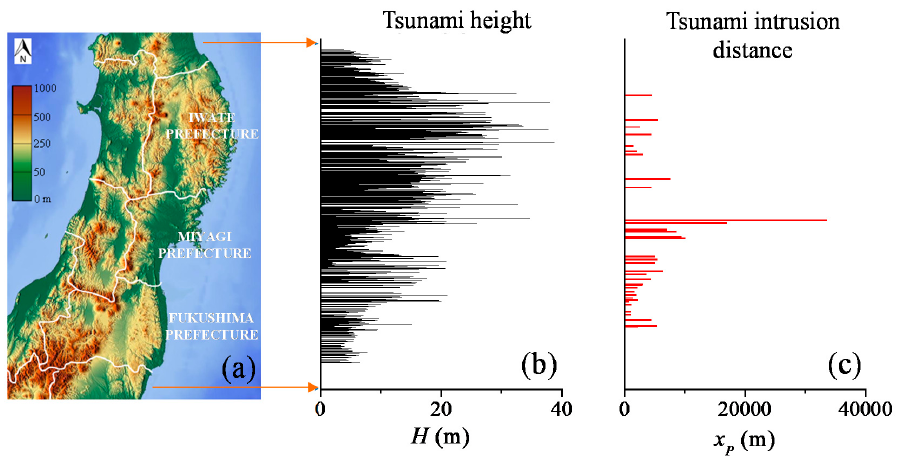
Figure 3. ( a ) Coastline from Iwate Prefecture to Fukushima Prefecture. ( b ) Coastal tsunami height. ( c ) River tsunami intrusion distance. J. Mar. Sci. Eng. 2020 , 8 , x FOR PEER REVIEW